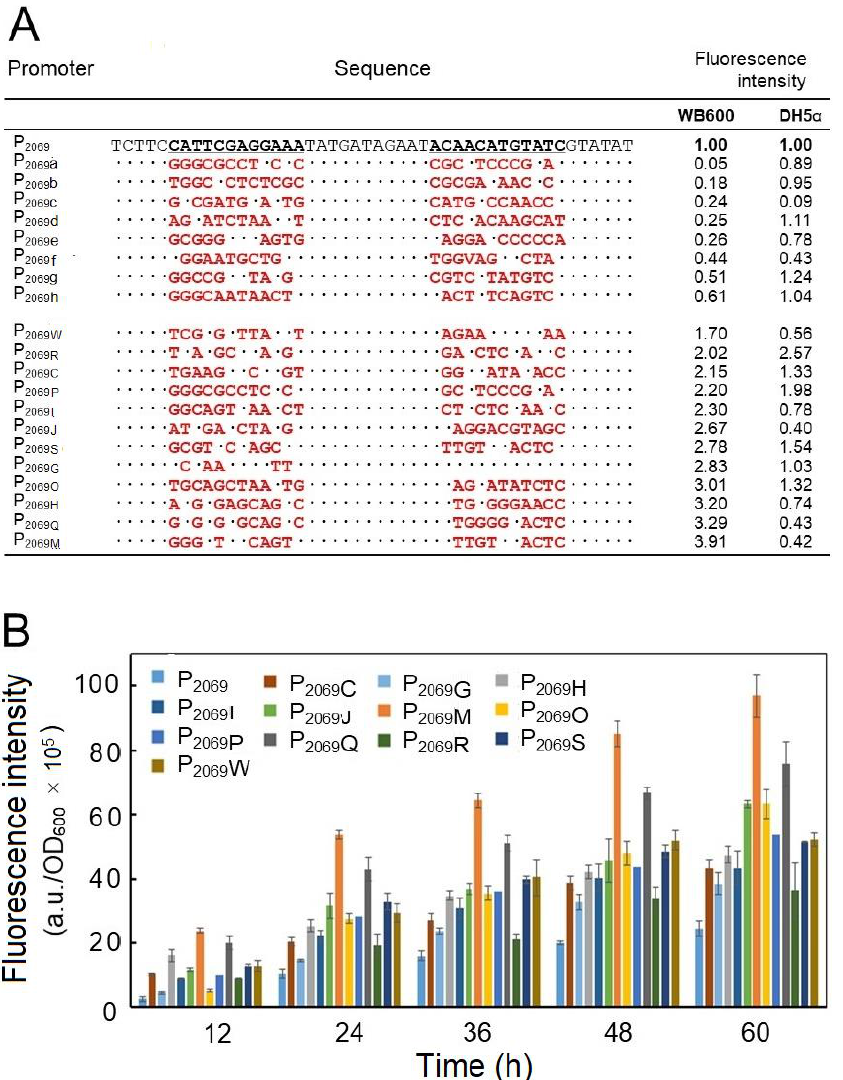
Figure 3. Engineering the promoter P 2069 . ( A ) DNA sequencing of the selected mutation promoters of P 2069 . The mutation promoters of P 2069 a to P 2069 h refer to 8 promoter variants with the reduced fluorescence intensity in comparison with the wild-type P 2069 and P 2069 W to P 2069M refer to 12 promoter variants with the enhanced fluorescence intensity; “.” indicates no change in the nucleotide; the red letters represent the altered nucleotide; The relative fluorescence intensities against the wild-type promoter P 2069 were measured at 24-h fermentation in B. subtilis and E. coli; ( B ) comparison of the promoter activity of the mutation promoters with the native P 2069 in driving GFP expression in B. subtilis